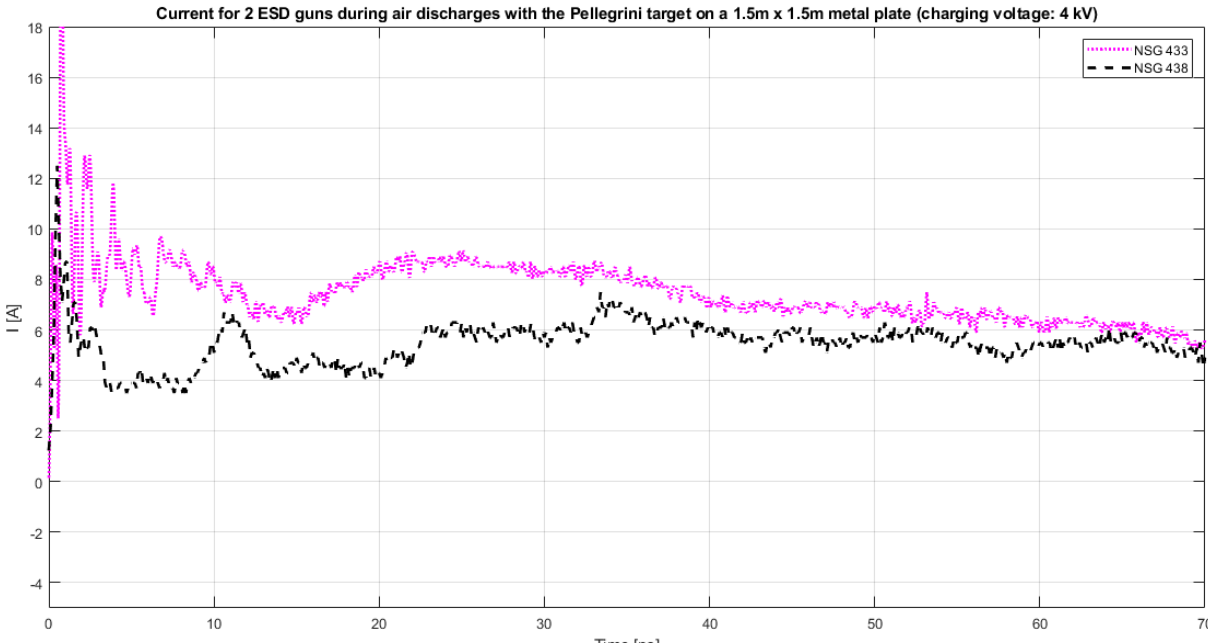
Figure 5. Typical current waveforms for air discharges from two different ESD guns when the charging voltage is +4 kV.